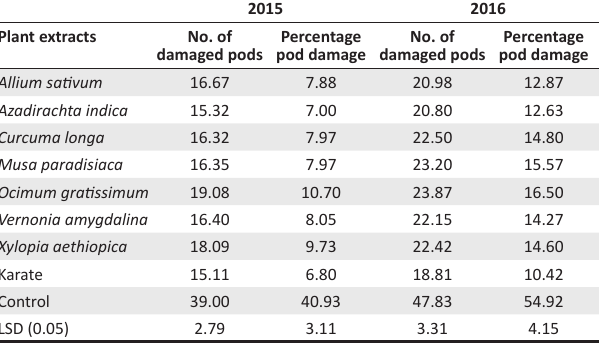
TABLE 6: Pod damage on mung bean treated with plant extracts and karate during 2015 and 2016 planting seasons. 2015